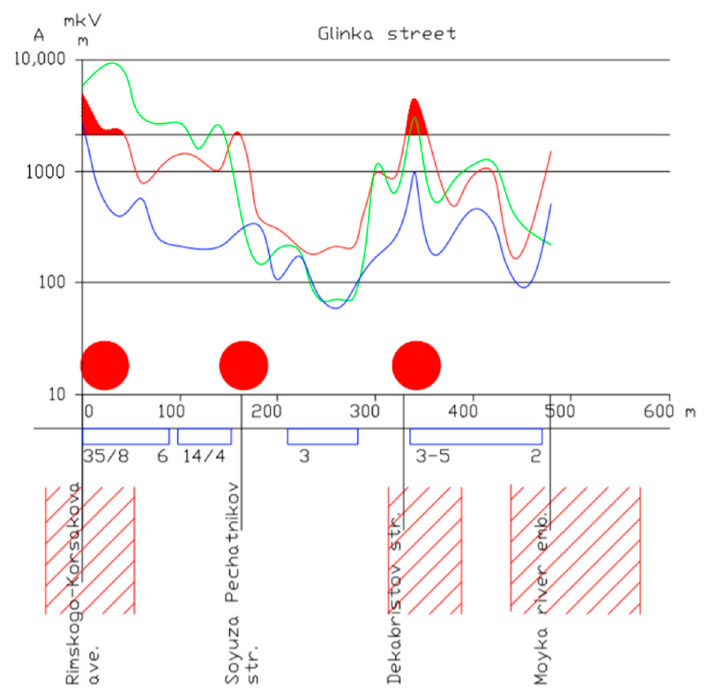
Figure 3. The results of the measurement of the ENPEMF MC along Glinka Street, Saint Petersburg, Russian